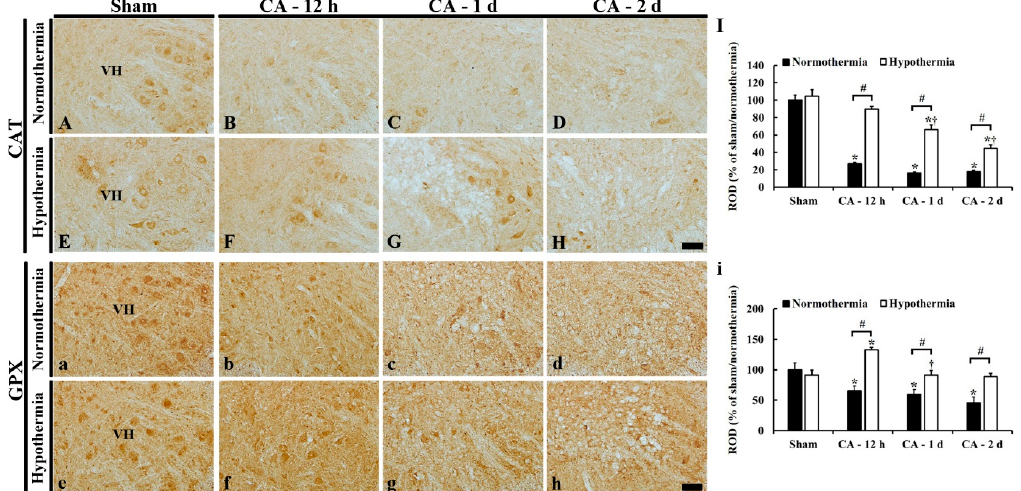
Figure 7. Immunohistochemistry of CAT ( A – H ) and GPX ( a – h ) in the lumbar ventral horn of the sham / normothermia ( A , a ), ACA / normothermia ( B – D , b – d ), sham / hypothermia ( E , e ), and ACA / hypothermia ( F – H , f – h ) groups. In the ACA / normothermia group, CAT immunoreactivity is dramatically decreased at 12 h after ACA and gradually decreased with time. In the ACA / hypothermia group, CAT immunoreactivity is similar to that in the sham / normothermia group, thereafter, CAT immunoreactivity is gradually decreased and very low at 2 days after ACA. GPX immunoreactivity in the ACA / normothermia group is gradually decreased with time. In the ACA / hypothermia group, GPX immunoreactivity at 12 h after ACA is significantly higher than that in the sham group, and GPX immunoreactivity is gradually reduced. VH, ventral horn. Scale bar = 100 µ m. ( I , i ) ROD as % of CAT ( I ) and GPX ( i ) immunoreactive structures in the lumbar ventral horn. The bars indicate the means ± SEM ( n = 5 and 7 for the sham and ACA group, * p < 0.05 vs. each sham group; # p < 0.05 vs. the ACA / normothermia group; † p < 0.05 vs. the previous time-point